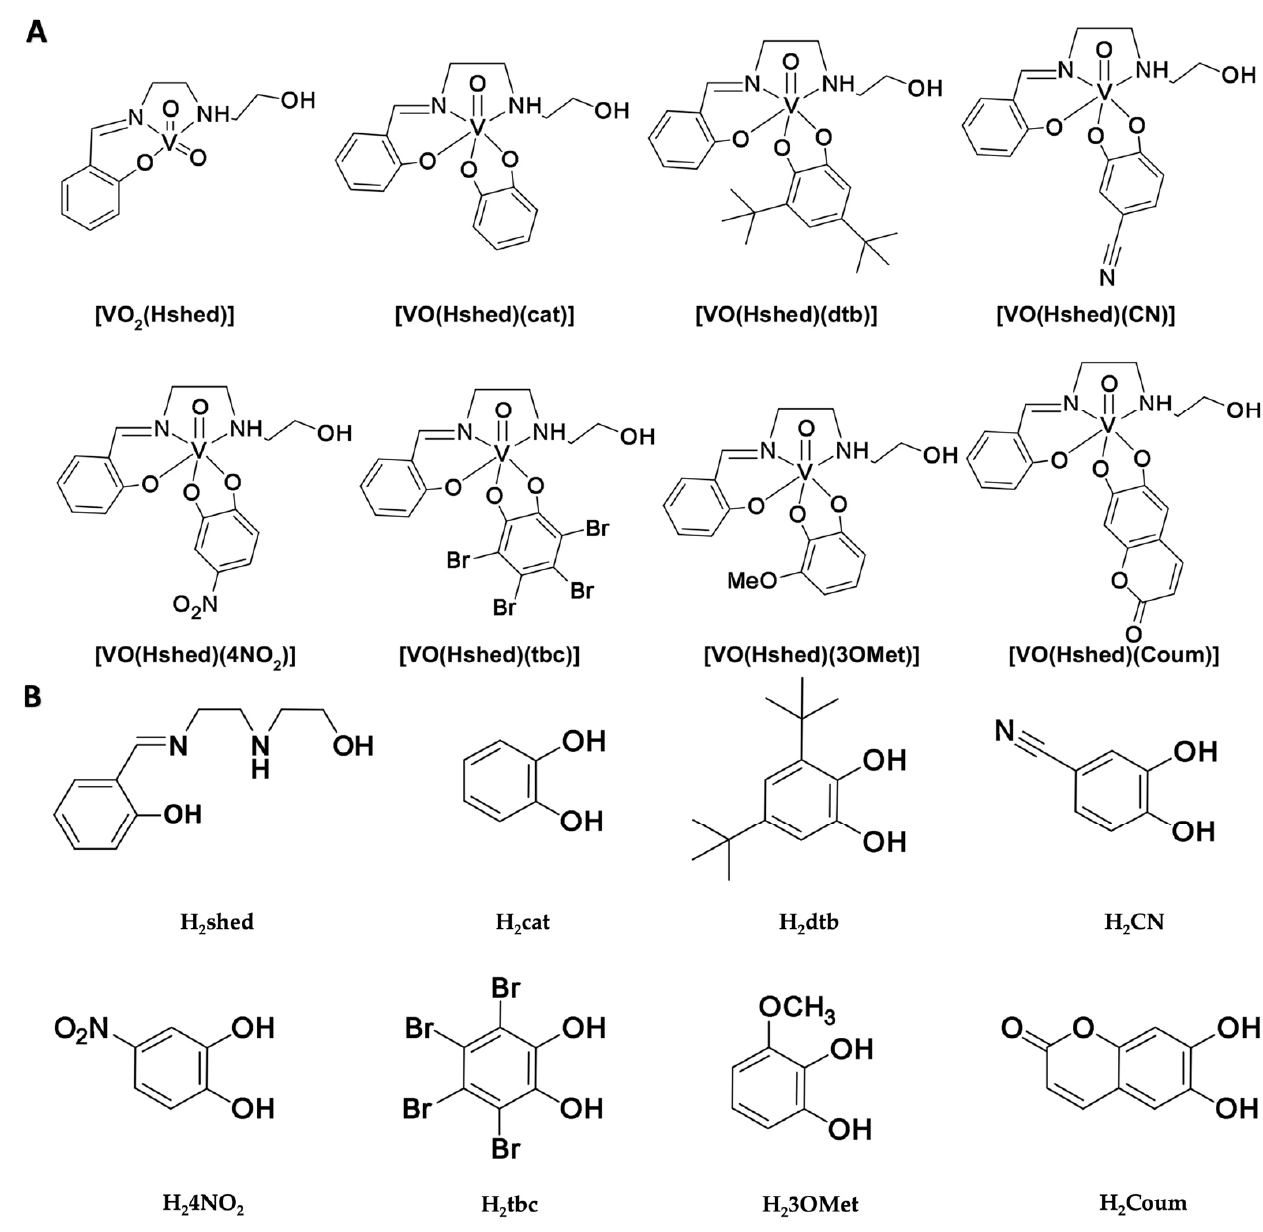
Figure 2. The schematic formulas for the ( A ) vanadium complexes and ( B ) free catechol